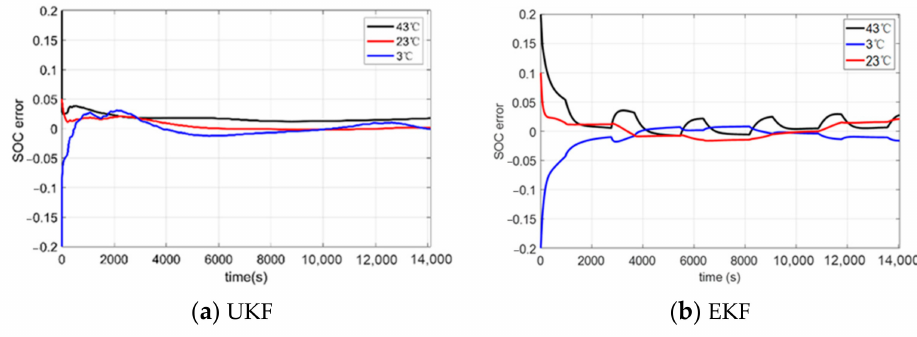
Figure 15. SOC estimation error for UDDS at different